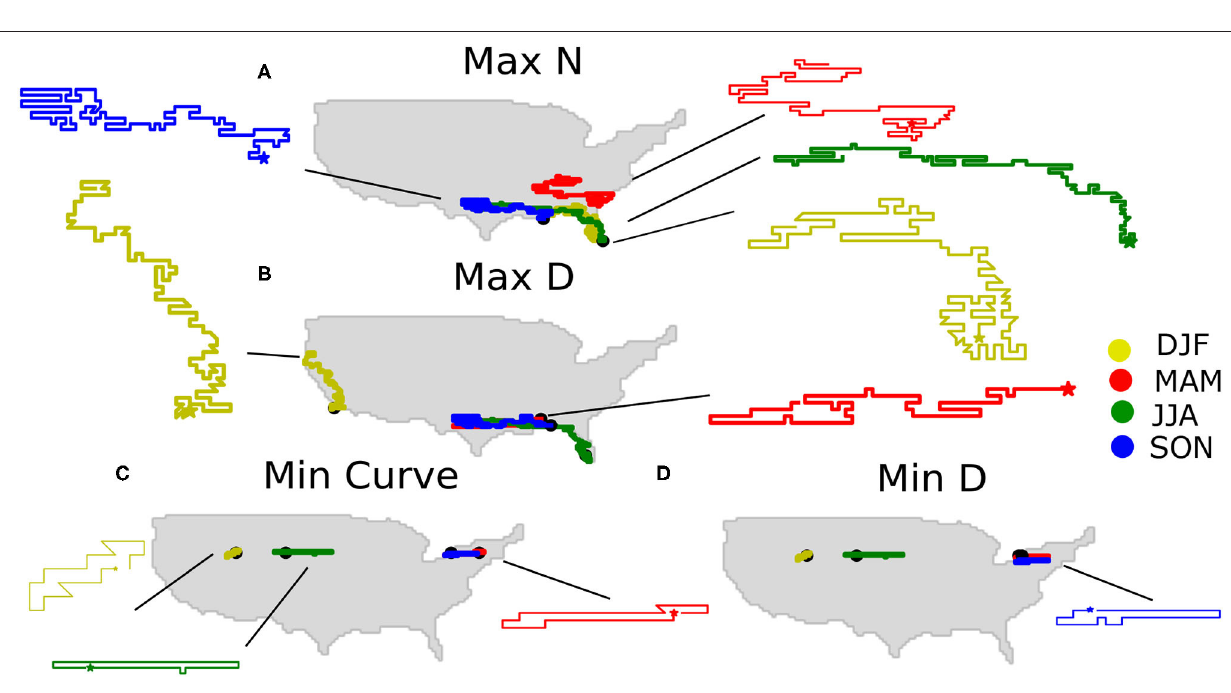
, and (D) minimum D . N